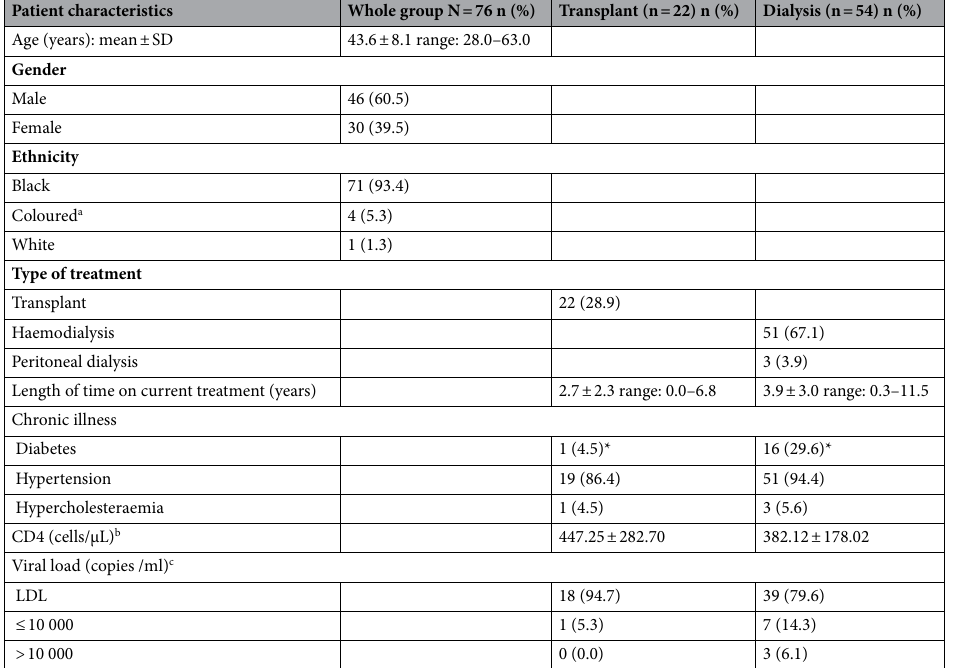
Table 1. Socio-demographic and clinical characteristics of the study sample. Data expressed as percentages or means with standard deviation. LDL: lower than detectable limit. *Significant difference in the number of patients with diabetes between transplant recipients and transplant candidates patients ( p = 0.017). a Coloured is the term used in South Africa denoting mixed racial ancestry. b Transplant patients: n = 20, dialysis recipients: n = 52. c Transplant patients: n = 19, dialysis patients: n = 49.